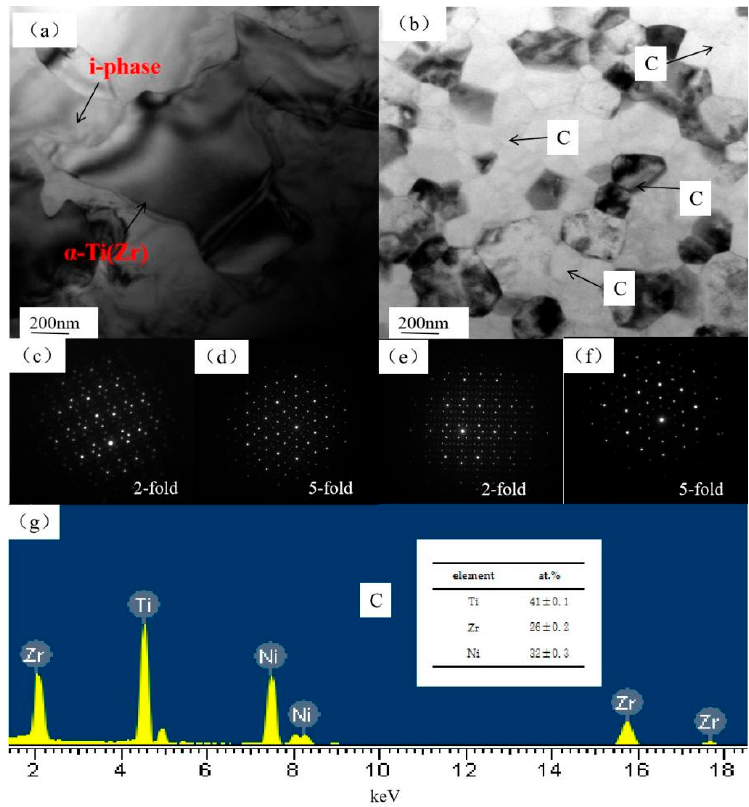
Figure 3. ( a ) TEM image, corresponding to ( c ) two-fold, and ( d ) five-fold of the I-phase of the Ti 40 Z r40 Ni 20 rod; ( b ) TEM image, corresponding to ( e ) two-fold, ( f ) five-fold, and ( g ) EDS spectrum of the I-phase (C) of the Ti 40 Z r40 Ni 20 ribbons.